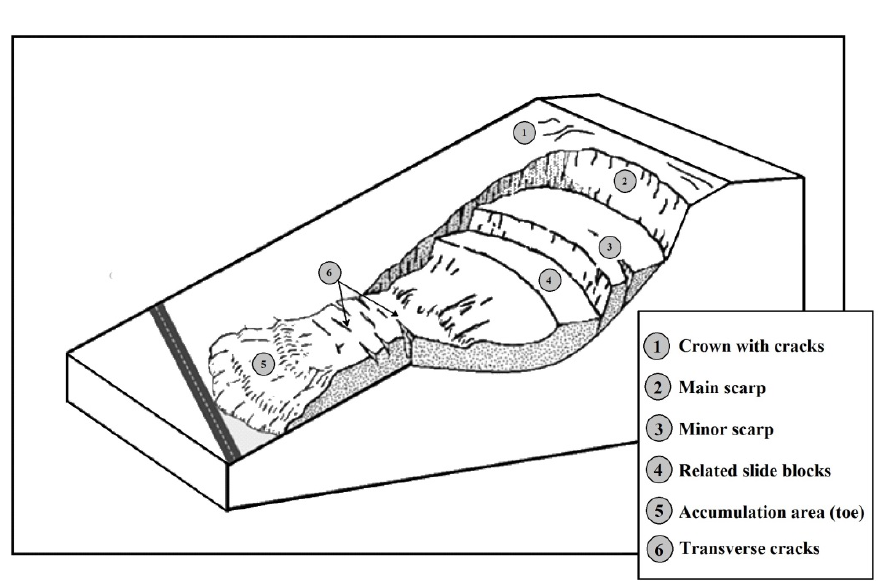
Figure 5. Geomorphologic characteristics of large-scale landslide (modified after Varnes [82]).